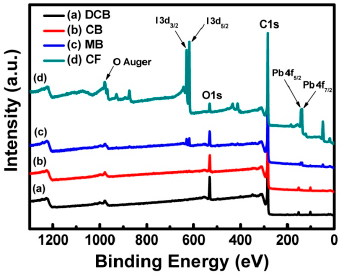
Figure 8. The XPS full spectrum analysis results for PCBM ETLs based on various solvents.